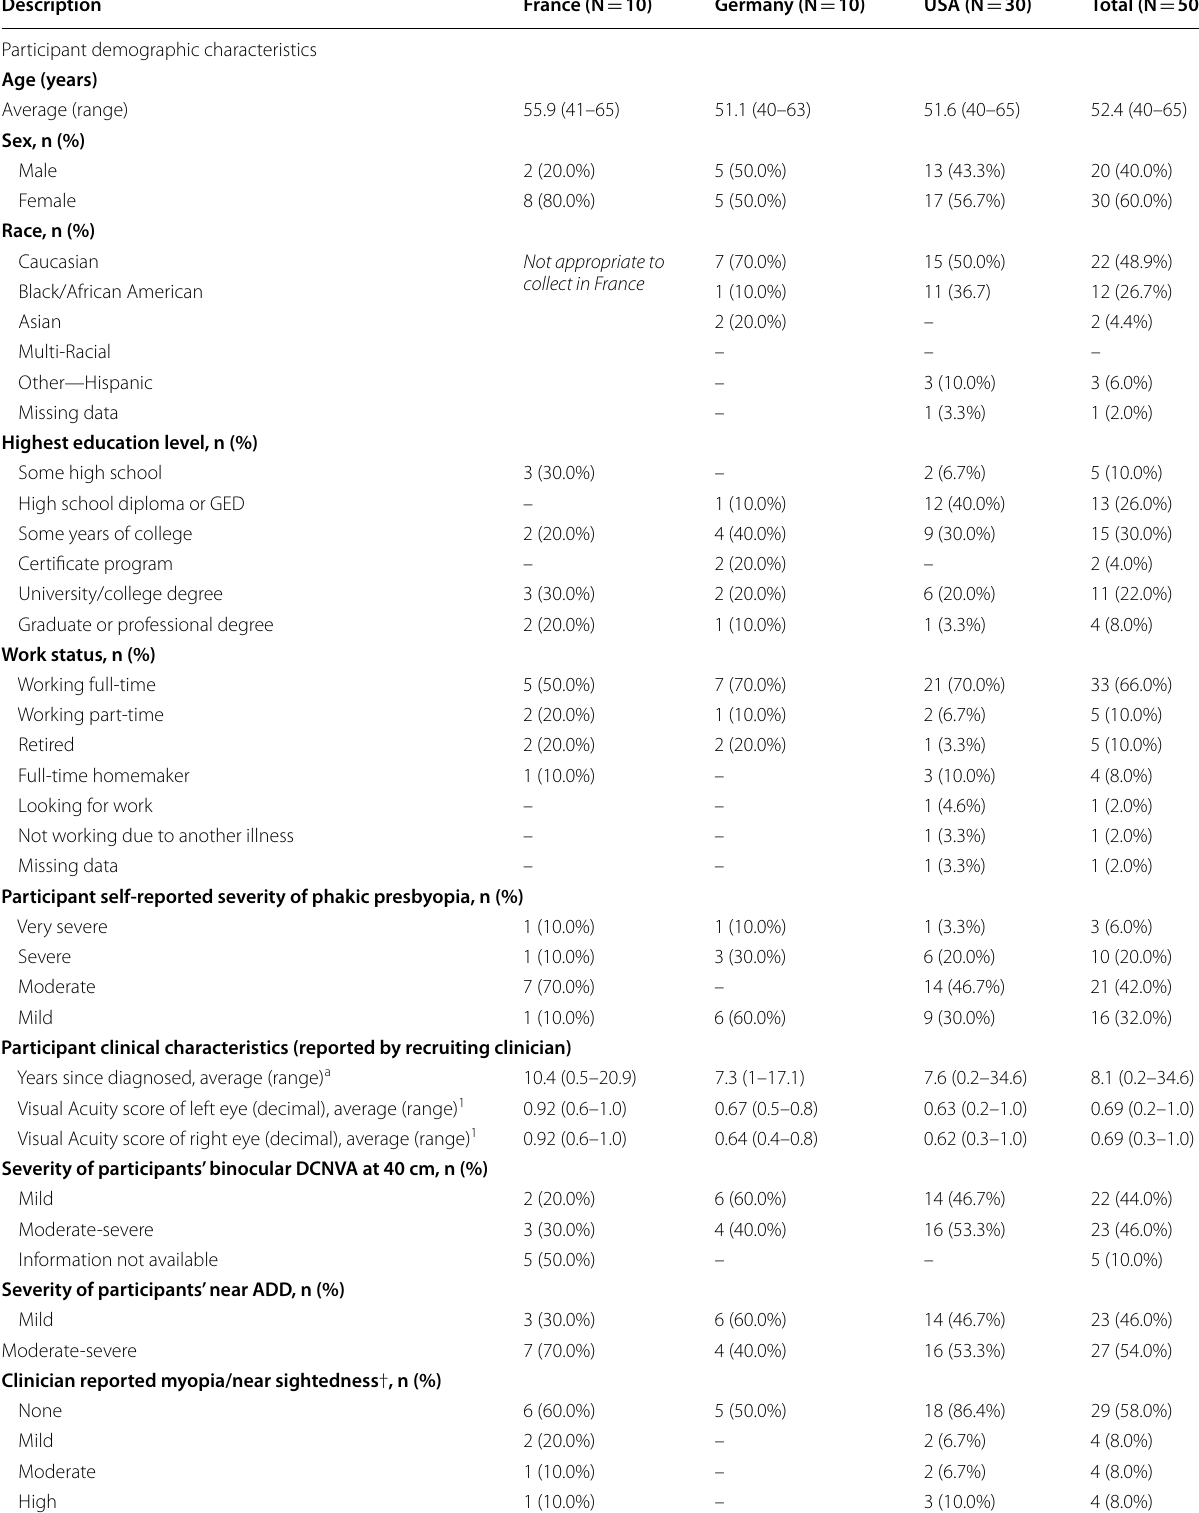
Table 2 Participant demographic and clinical